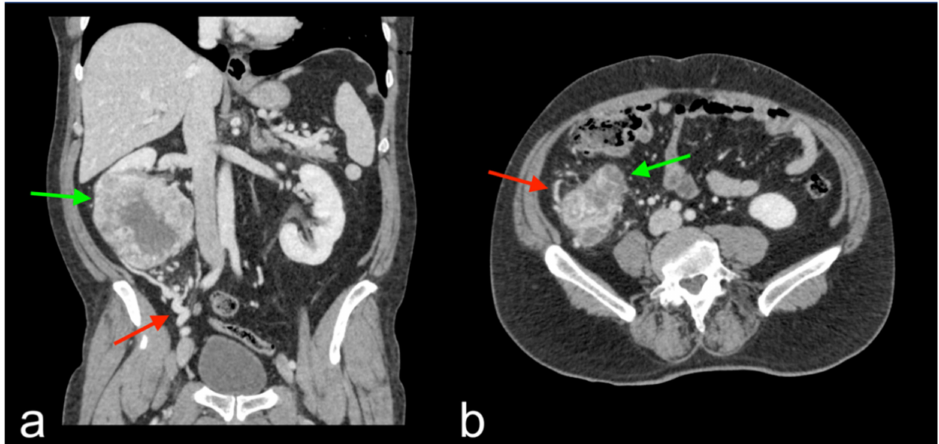
Figure 1. CT images in the coronal ( a ) and axial ( b ) planes of the abdomen in the venous phase, showing the presence of collateral vessels (red arrows) adjacent to clear cell renal cell carcinoma with a high Fuhrman grade (IV) (green arrow), with the characteristic tortuous course within the perinephric adipose